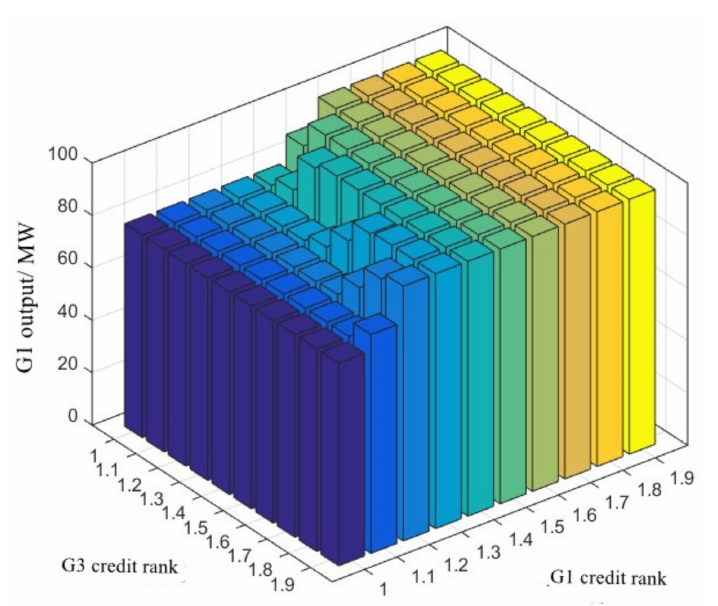
Figure 7. Residual change of synchronous ADMM.